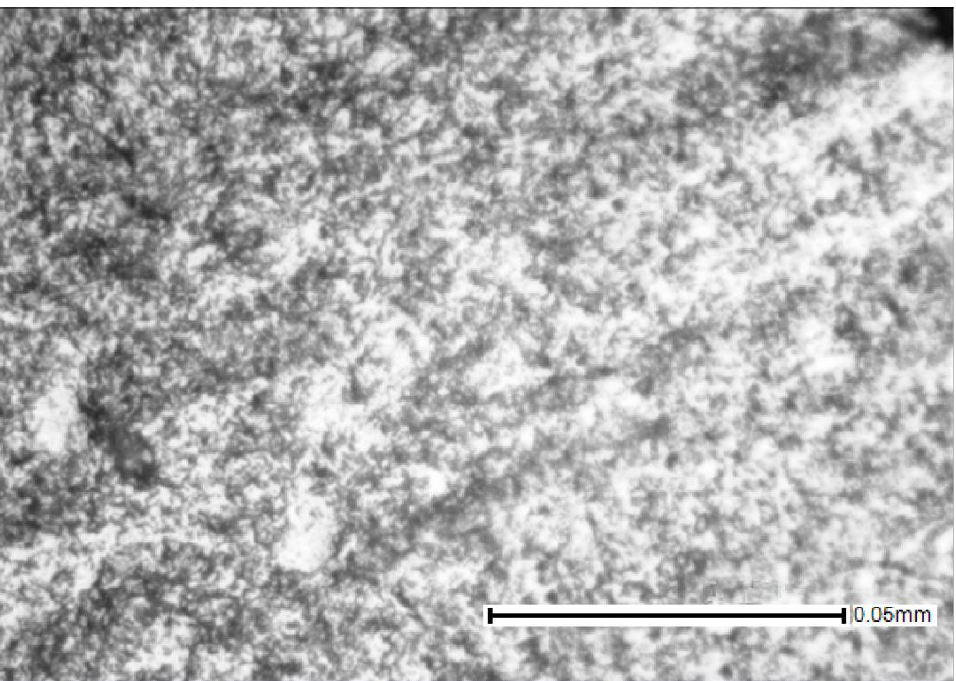
Materials 2020 , 13 , x FOR PEER REVIEW Figure 7. Microstructure of Ti–28Nb–5Zr wire after drawing. Figure 7. Microstructure of Ti–28Nb–5Zr wire after drawing.